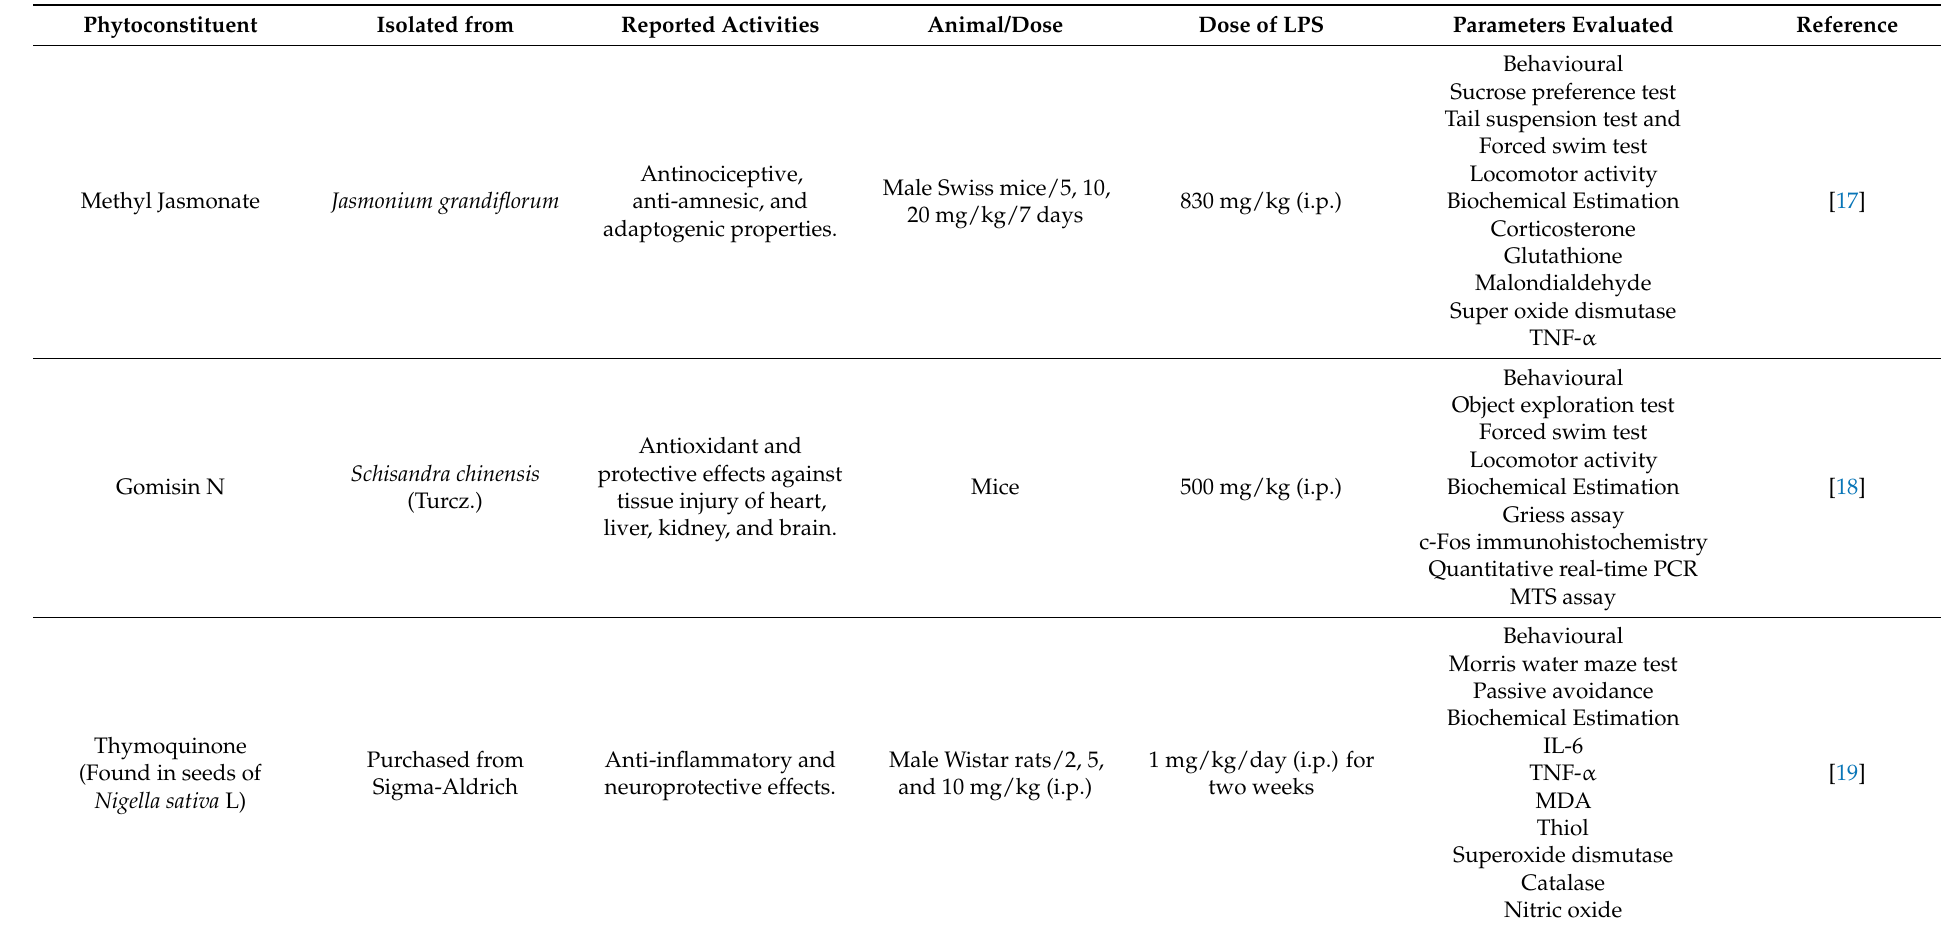
Table 1. Herbal bioactive compounds conferring protection against LPS-induced sickness behaviour in